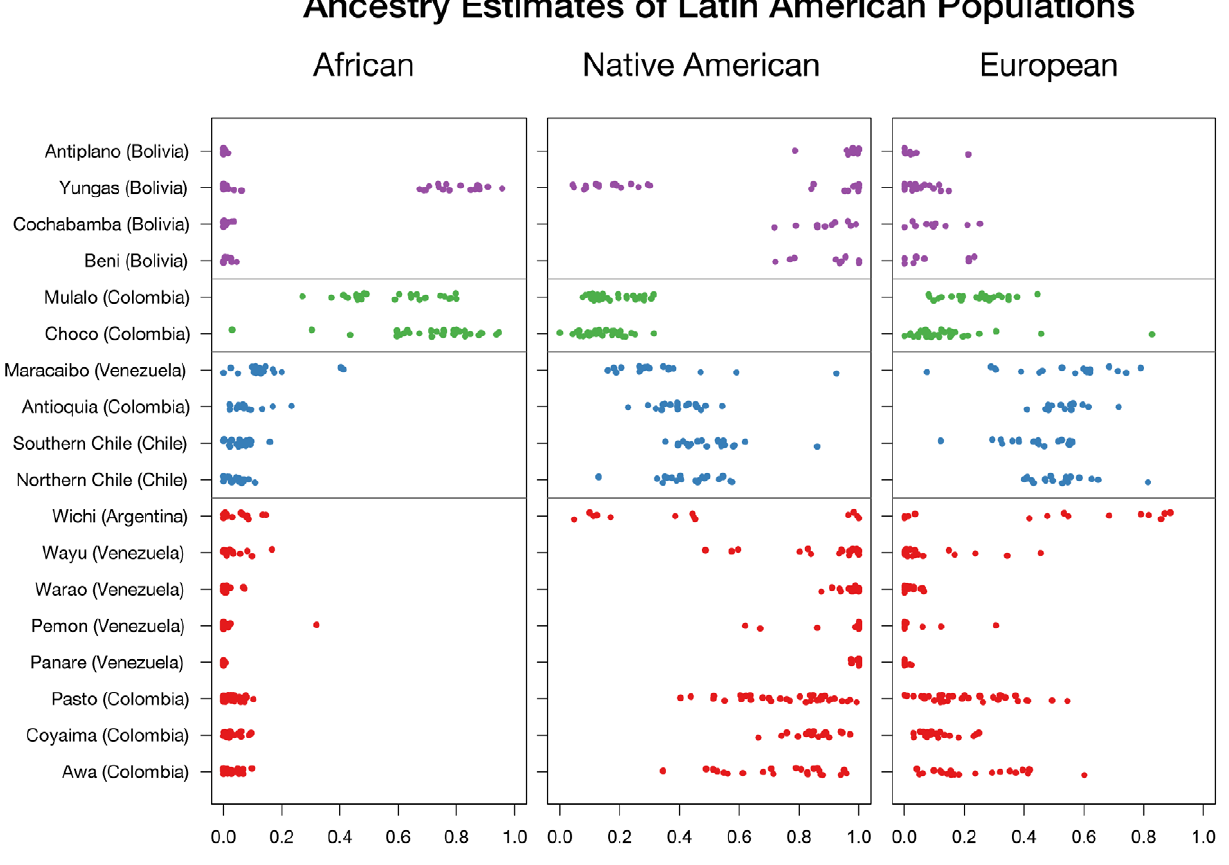
Figure 3. Ancestry estimates of Latin American populations.